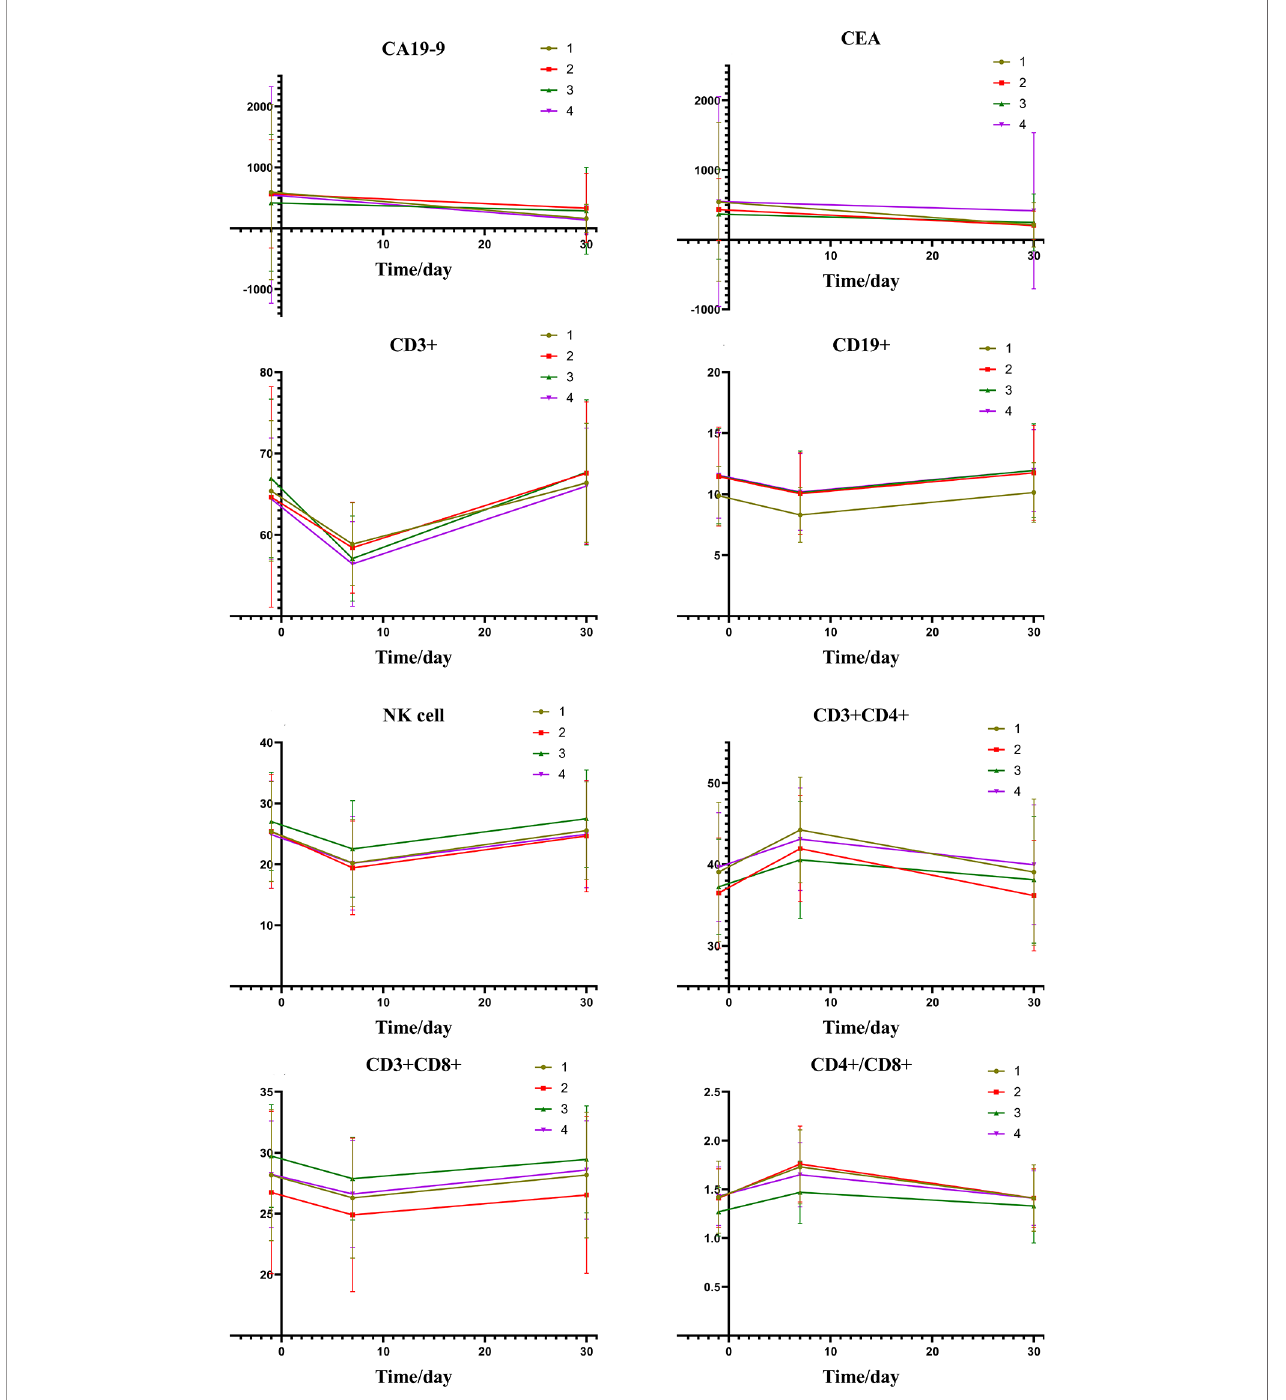
FIGURE 2 | Group1: low pre-expression of HMGB1 with c-TACE; Group2: high pre-expression of HMGB1 with c-TACE; Group3: low pre-expression of HMGB1 with DEB-TACE; Group4: high pre-expression of HMGB1 with